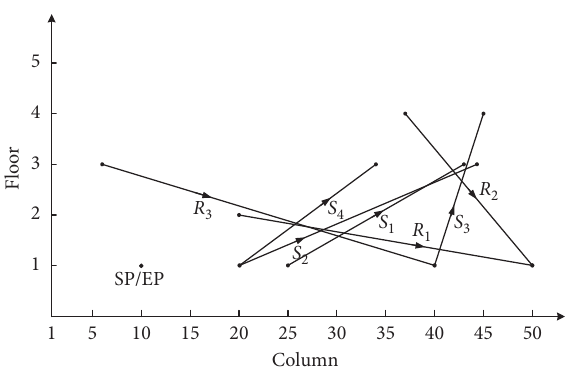
Figure 10: Optimal solution of execution sequence of S/R requests sequence: the horizontal axis and the vertical axis represent the column and floor, where the stacker access point is located, re- spectively, the solid line represents load travel, and the dotted line represents no-load travel.